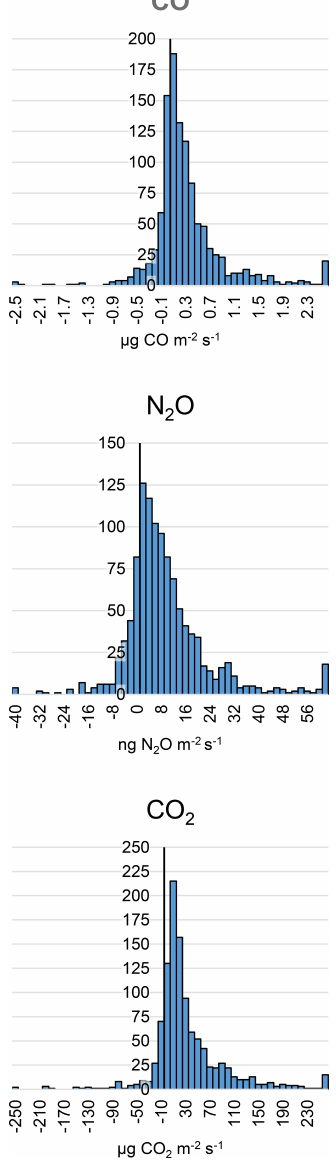
Figure 4. Frequency distributions of wintertime natural landscape (agricultural fields, forests)